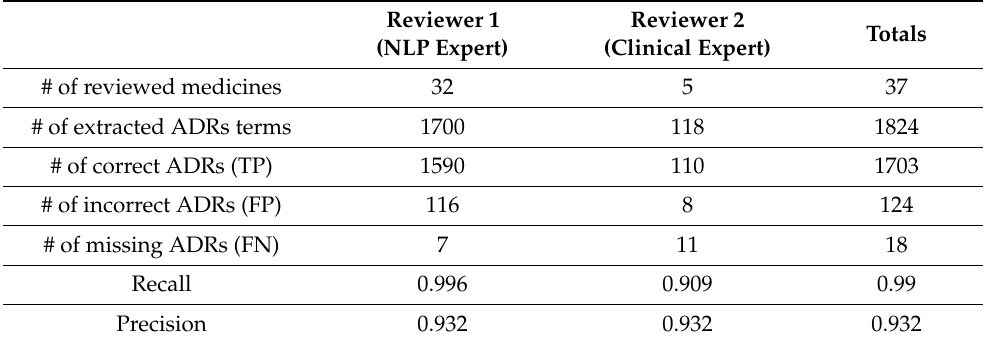
Table 3. Final results of the manual expert reviews.